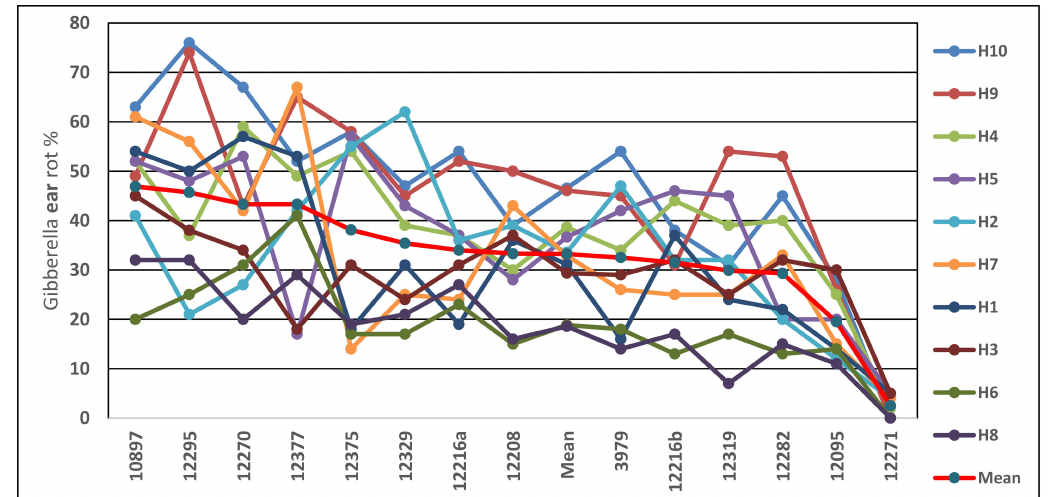
Figure 9. The GER kernel infection severity of 14 F. graminearum and F. culmorum isolates in maize hybrid resistance tests with 10 hybrids (H1-H10)